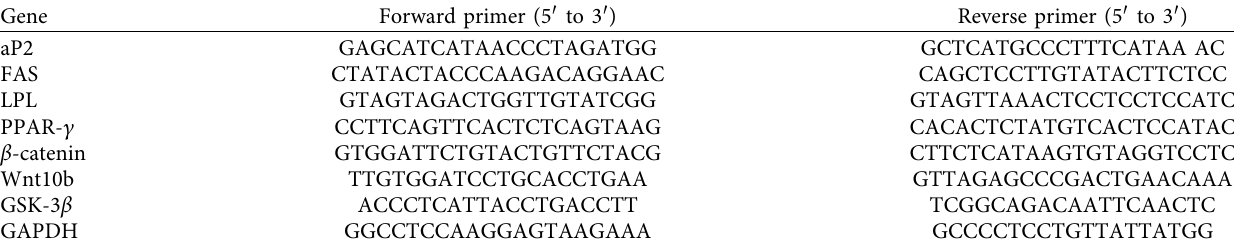
Table 1: Primers used for real-time